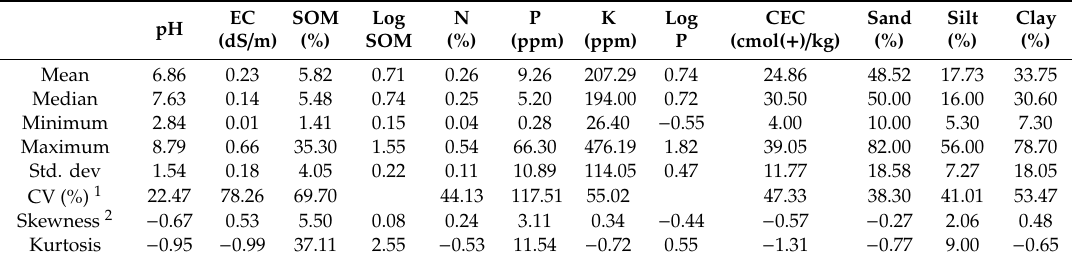
Table 4. Descriptive statistical analysis of soil properties in the study area ( n = 72) in the Jucusbamba and Tincas microwatersheds (Amazonas, NW Peru). EC SOM (dS / m) (%)